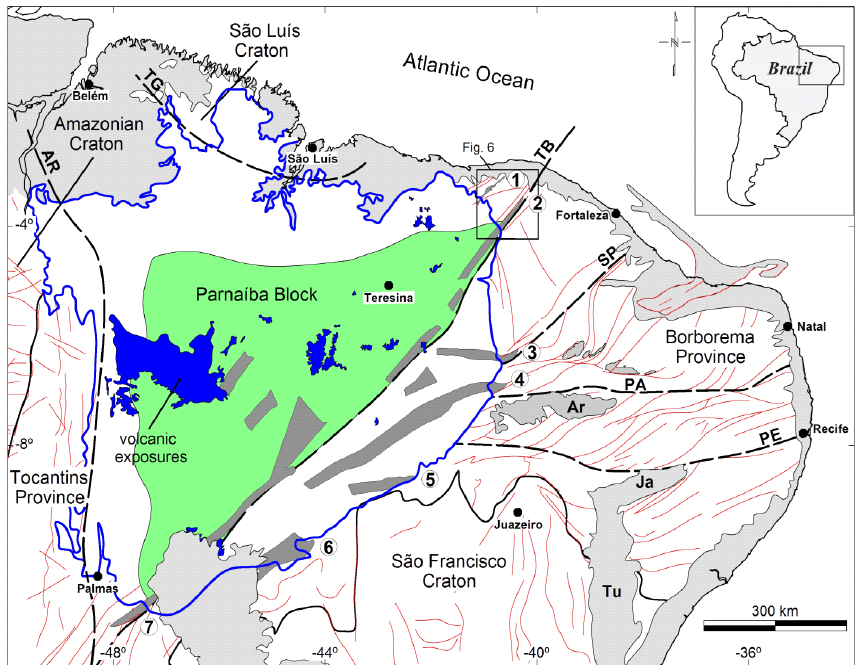
Figure 2. Schematic geological map of NE Brazil showing the Parnaíba basin (blue line) and its Precambrian basement structures (red lines) (adapted from de Castro, 2011, and Oliveira and Mohriak, 2003). Gray areas correspond to Mesozoic to recent sedimentary covers. Labeled dark gray areas correspond to exposures of Cambrian–Ordovician troughs and their supposed prolongation beneath the sag basin: 1 – Jaguarapi; 2 – Jaibaras; 3 – Cococi; 4 – São Julião; 5 – São Raimundo Nonato; 6 – Correntes; 7 – Monte do Carmo. Brasiliano shear